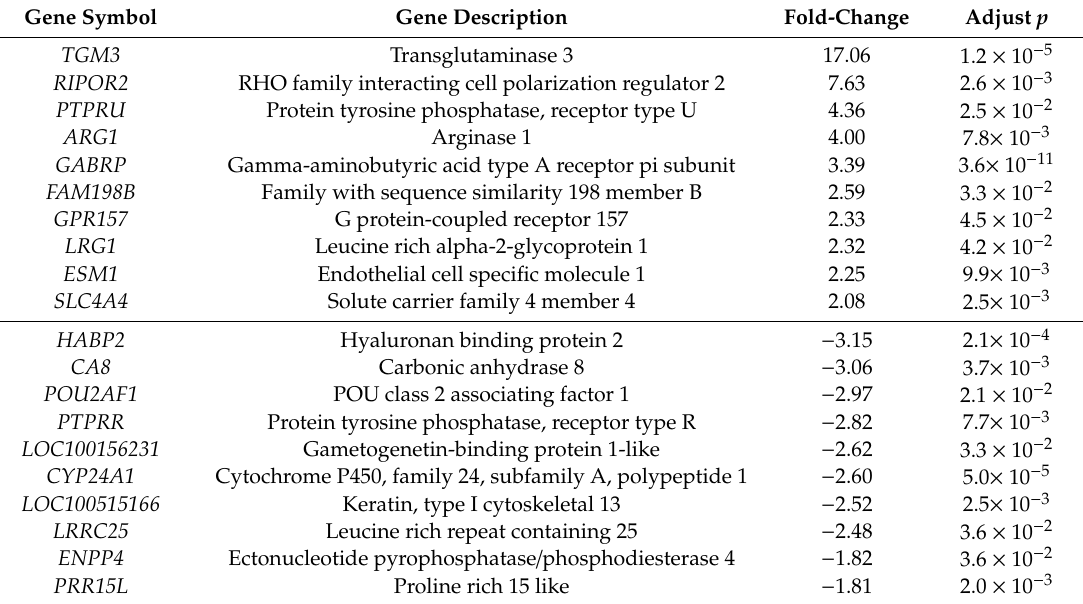
Table 2. Highly di ff erentially expressed genes in LPA plus KA-1002 treated vs. LPA treated swine